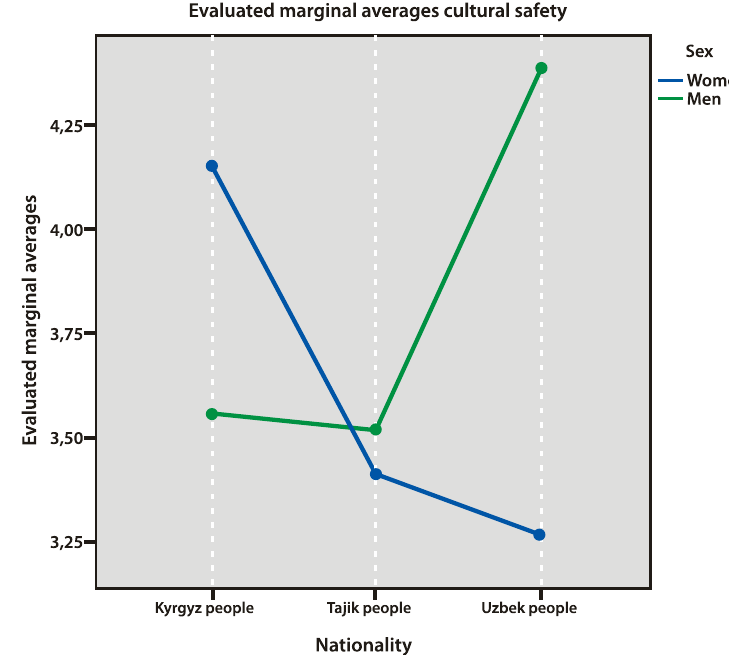
Figure 5. Cultural safety factors.